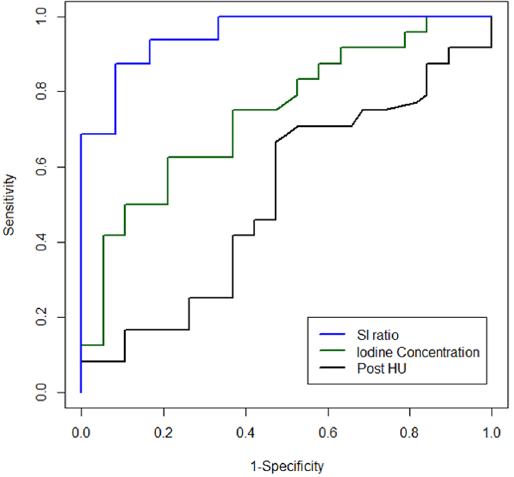
Figure 4. ROC curves of post-contrast HU, iodine concentration, and SI ratios. The AUC of iodine concentration was higher than that of post-contrast value in HU (AUC; 0.51 vs. 0.77; p < 0.001), and lower than of the SI ratio (AUC; 0.77 vs. 0.89; p =